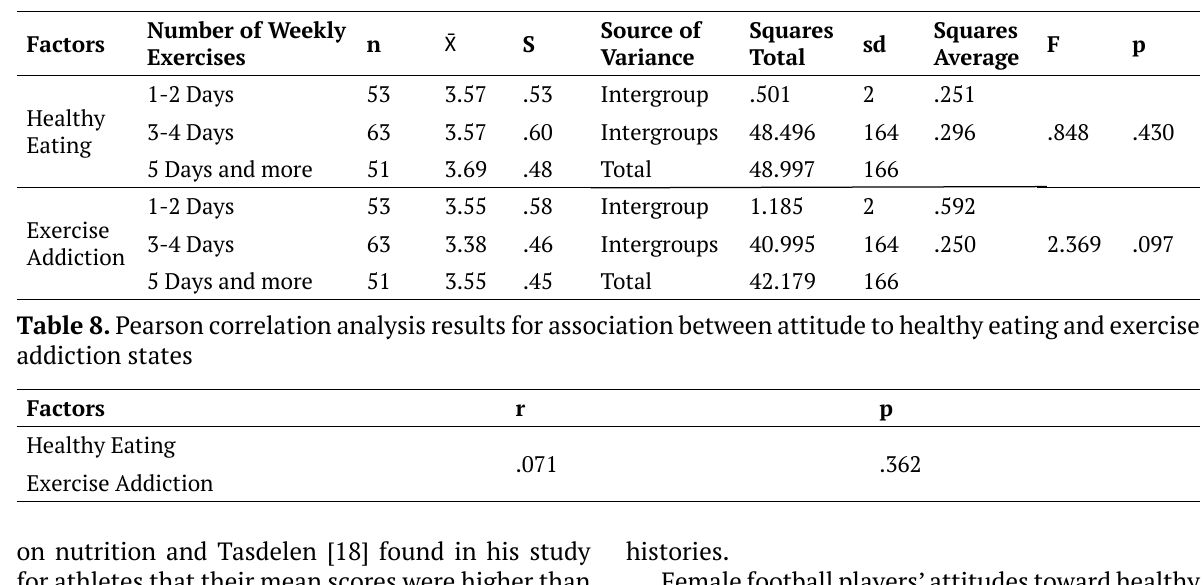
Table 7. ANOVA results by weekly training count of female football players’ attitudes and exercise addiction to healthy eating